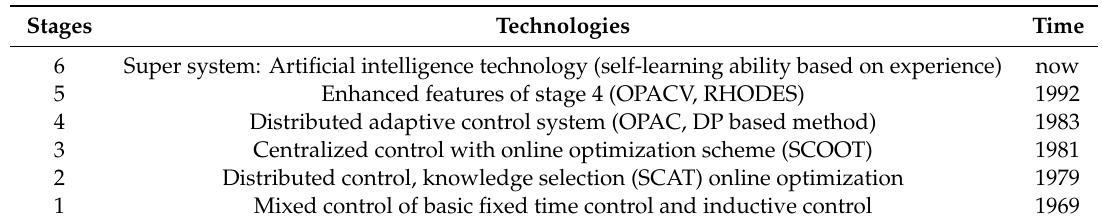
Table 1. Development history of adaptive tra ffi c signal